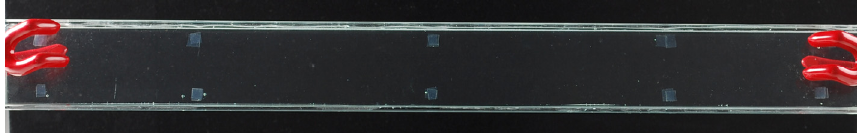
Figure 11: Specimen after climate test according to